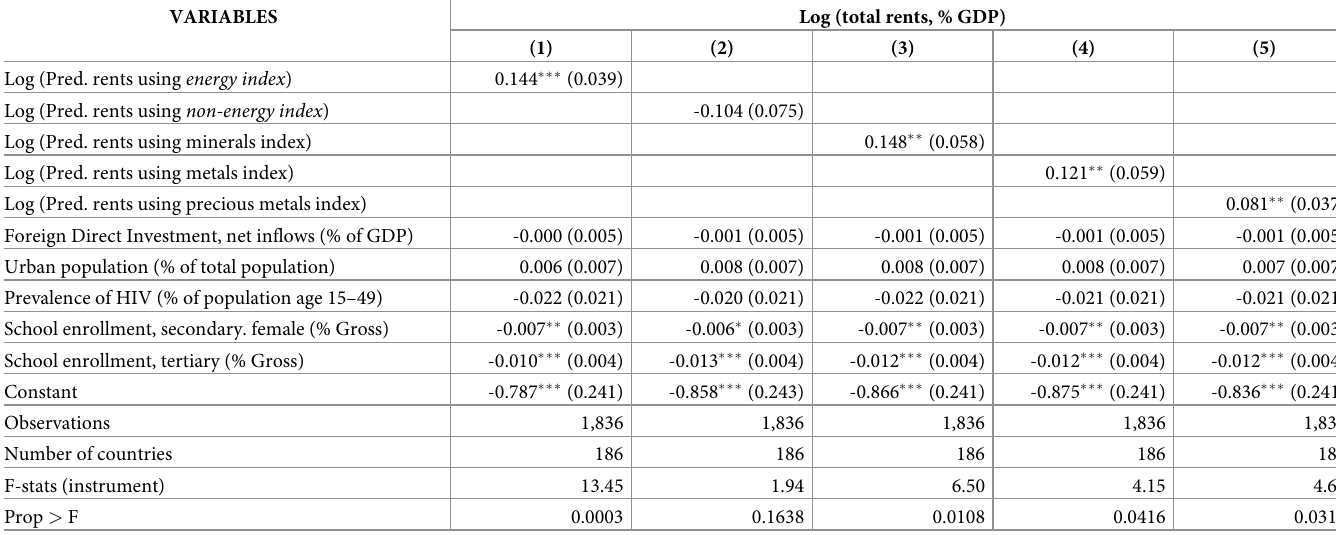
Table 2. First stage regression: Predicting rents with global price indices.